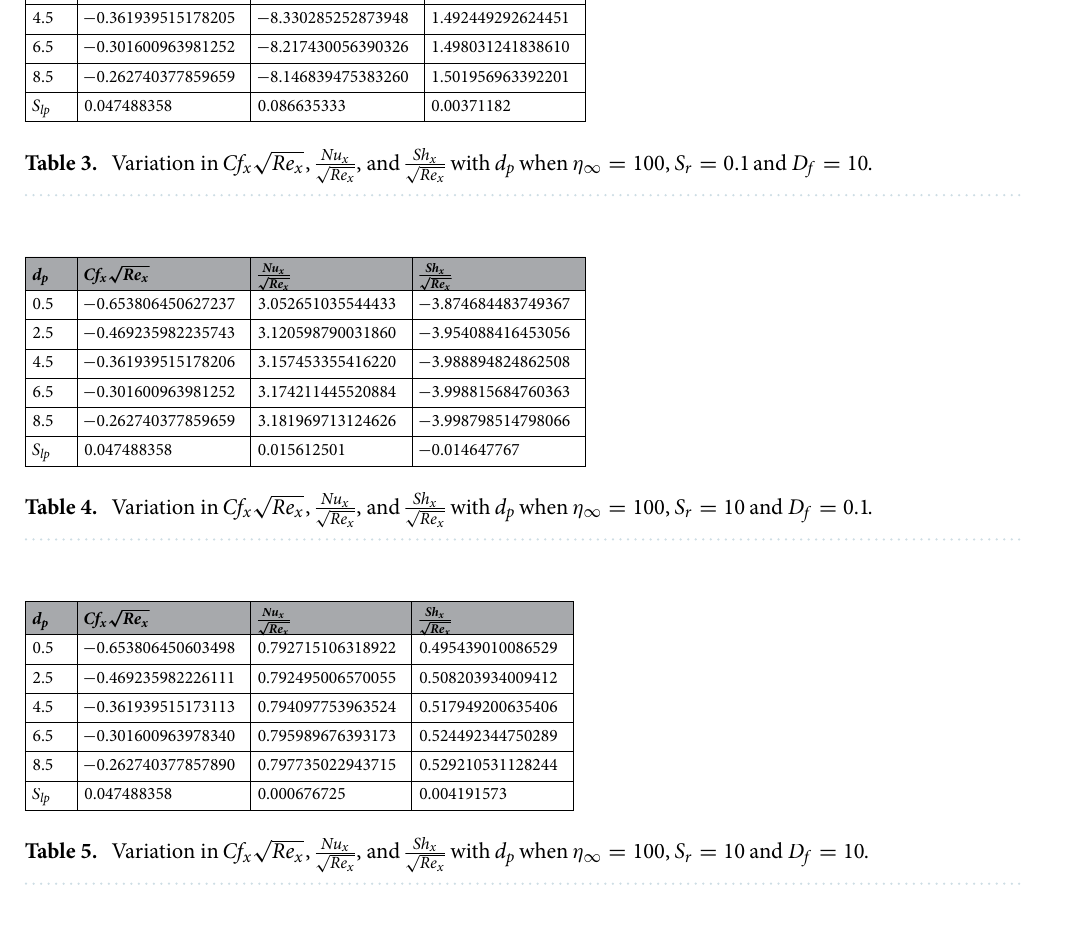
, and Sh x with d p when η √ Re x √ Re x